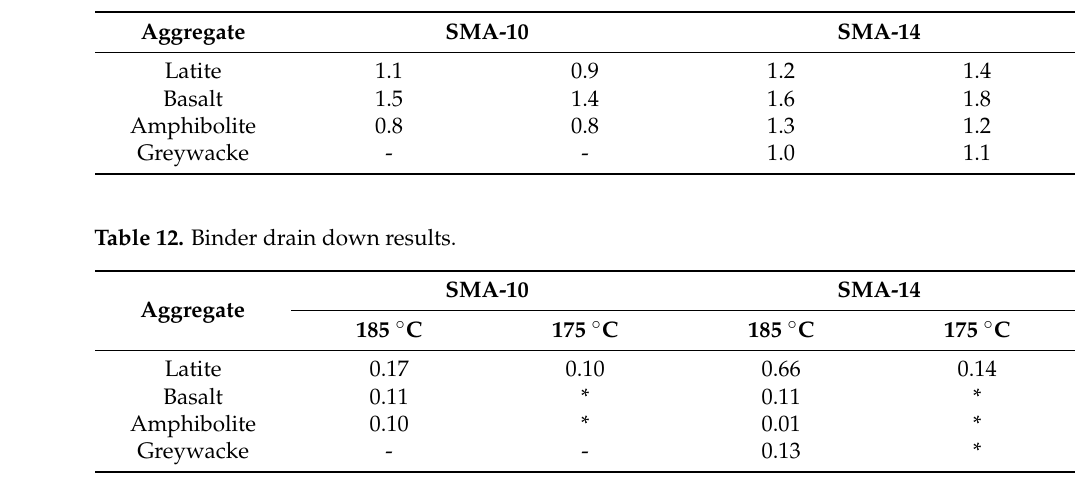
Table 11. Surface texture results (duplicate) (mm).